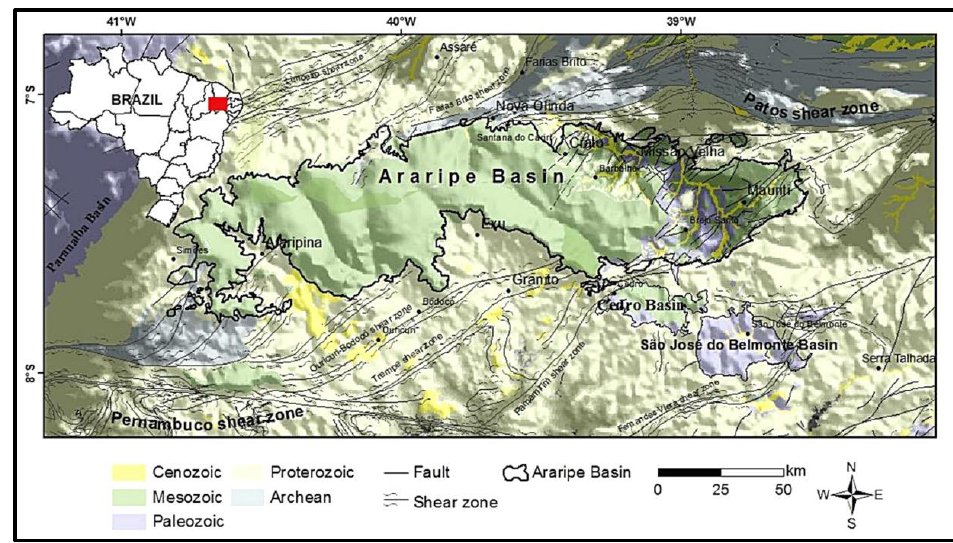
Figure 6. Simplified geological map of the Araripe Basin. Source: Miranda et al. 2014 [103] .